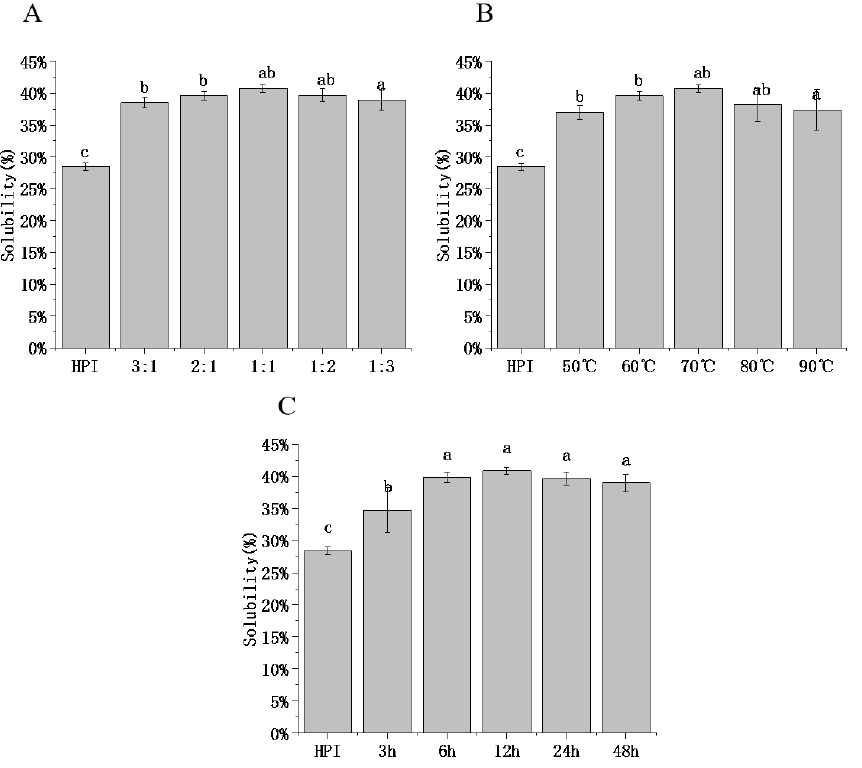
Figure 4. Effect of hemp protein isolate (HPI) ratios to pullulan ( A ), incubation temperature ( B ), and incubation time ( C ) on the solubility of glycosylated HPI. Different superscript letters represent a significant difference ( p < 0.05).